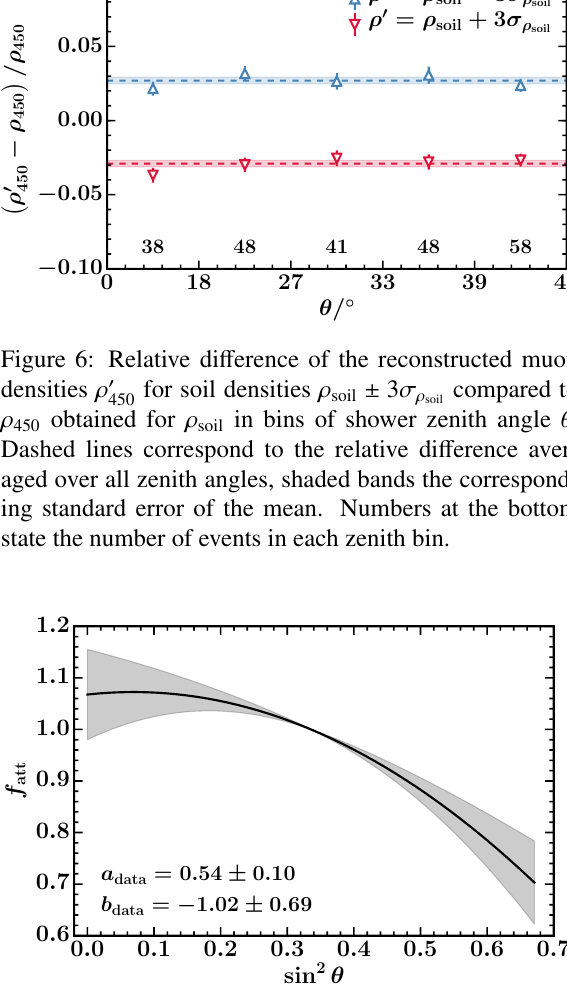
Figure 7: Muon attenuation function obtained with the CIC method from data of the AMIGA prototype array; the parametrization uncertainty is shown by a shaded